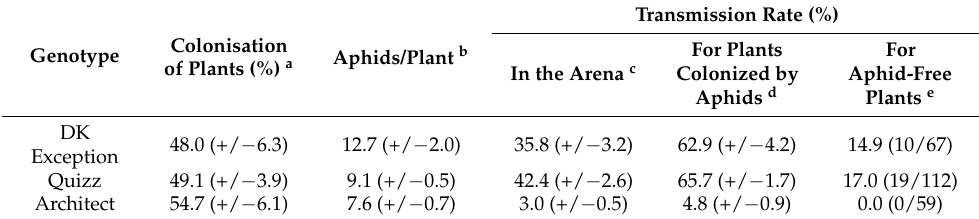
Table 1. Monitoring of aphids on plants in arena